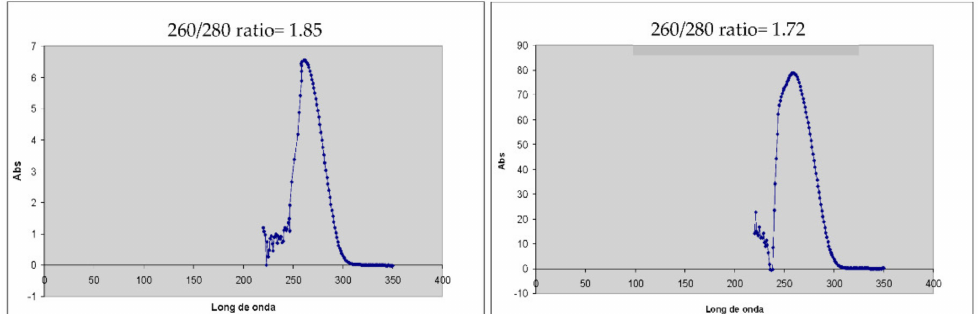
Figure 14. Quantification and quality analysis of the total cDNA extracted for each of the samples subsequently used for expression analyses by using absorbance curves based on